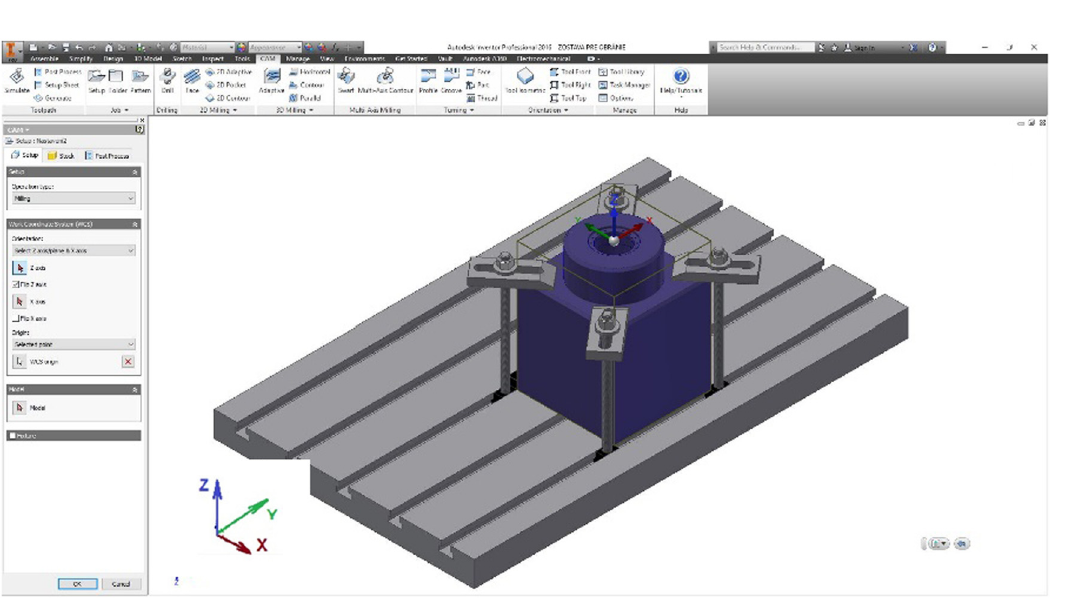
(cid:129) Carbide 4 – plate cutter with a diameter of Ø 20 mm, and (cid:129) ISCAR BHF - MB50 - 80 boring bar.